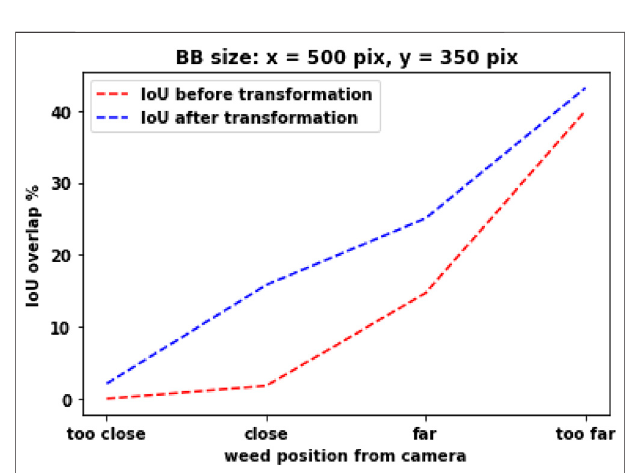
FIGURE6 | IOU overlap value withrespect todistance from thecamera. (A) BB size, width: 500 pixels; height: 350 pixels. (B) BB size, width: 450 pixels; height: 300